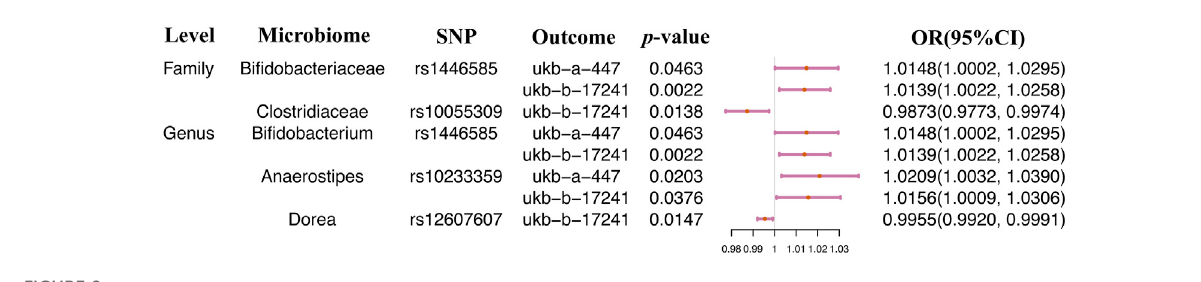
FIGURE 2 Single SNP analysis between the gut microbiome and eczema, hay fever, and allergic rhinitis.